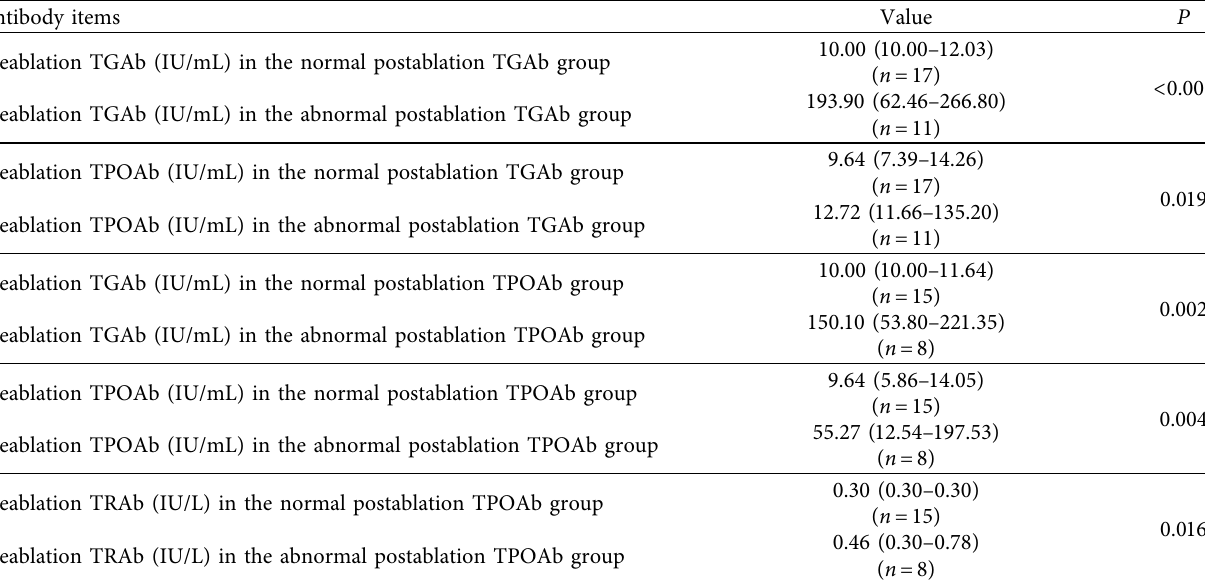
Table 5: Preablation and postablation antibody values in different antibody groups after microwave ablation of papillary thyroid cancer. Antibody